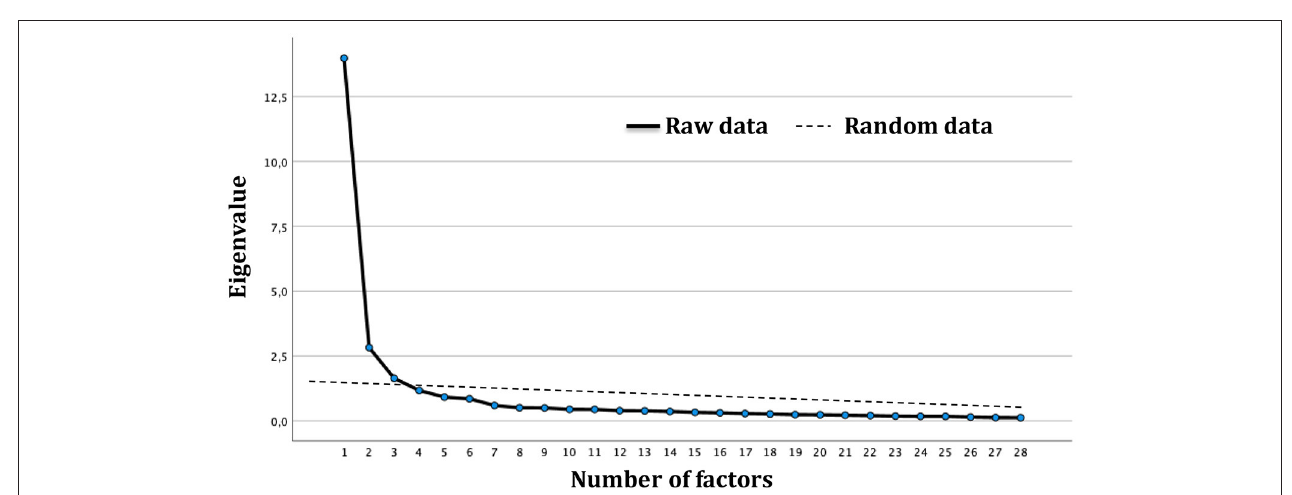
FIGURE 1 | Scree plot from the principal axis analysis and parallel analysis conducted on Resilience Scale in subsample 1.